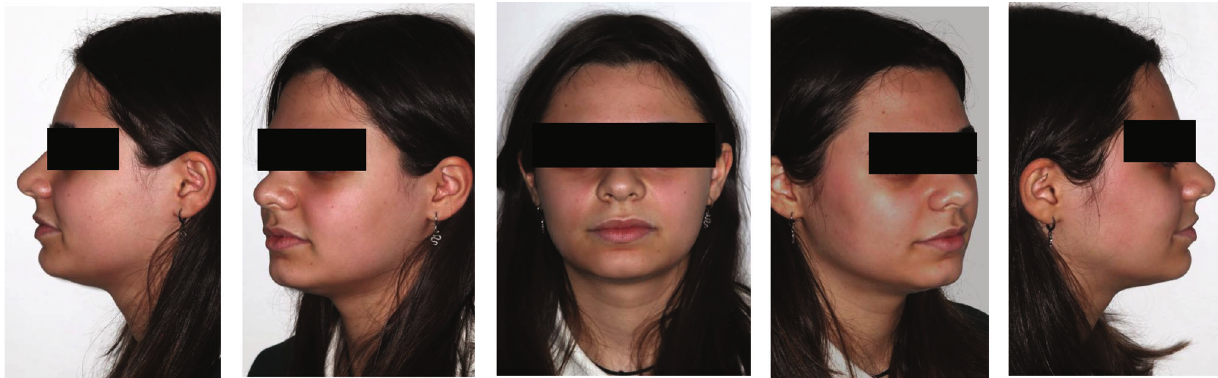
Figure 13: Final extraoral